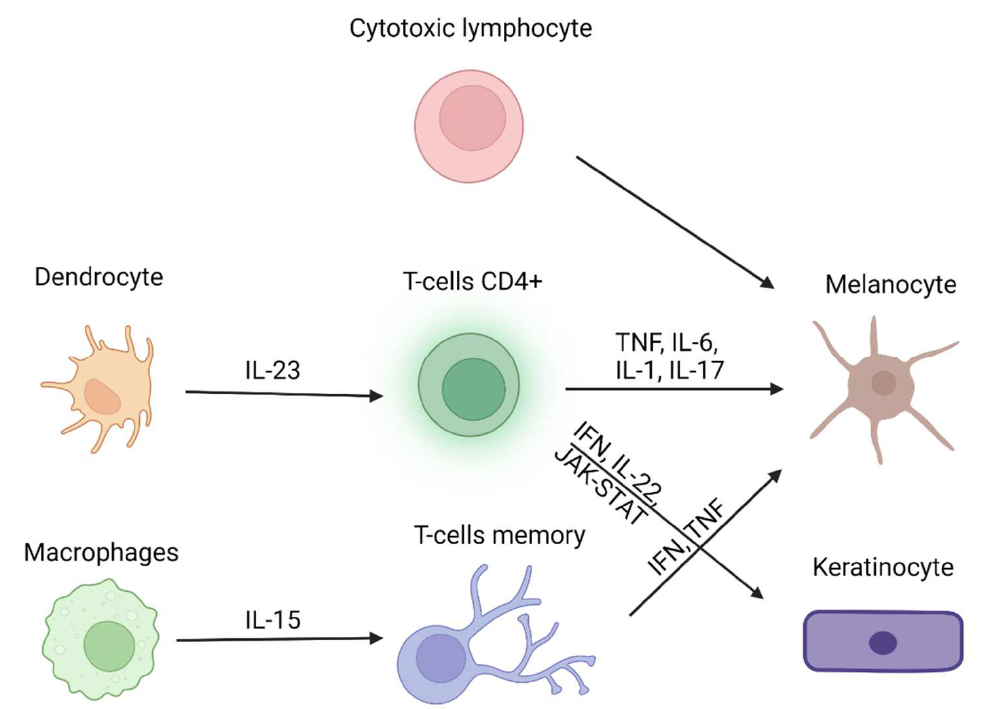
Figure 1. Main cell populations and cytokines involved in vitiligo (modified from Role of Cytokines in Vitiligo: Pathogenesis and Possible Targets for Old and New Treatments [3]). Created with BioRender.com (accessed on 1 November 2022).